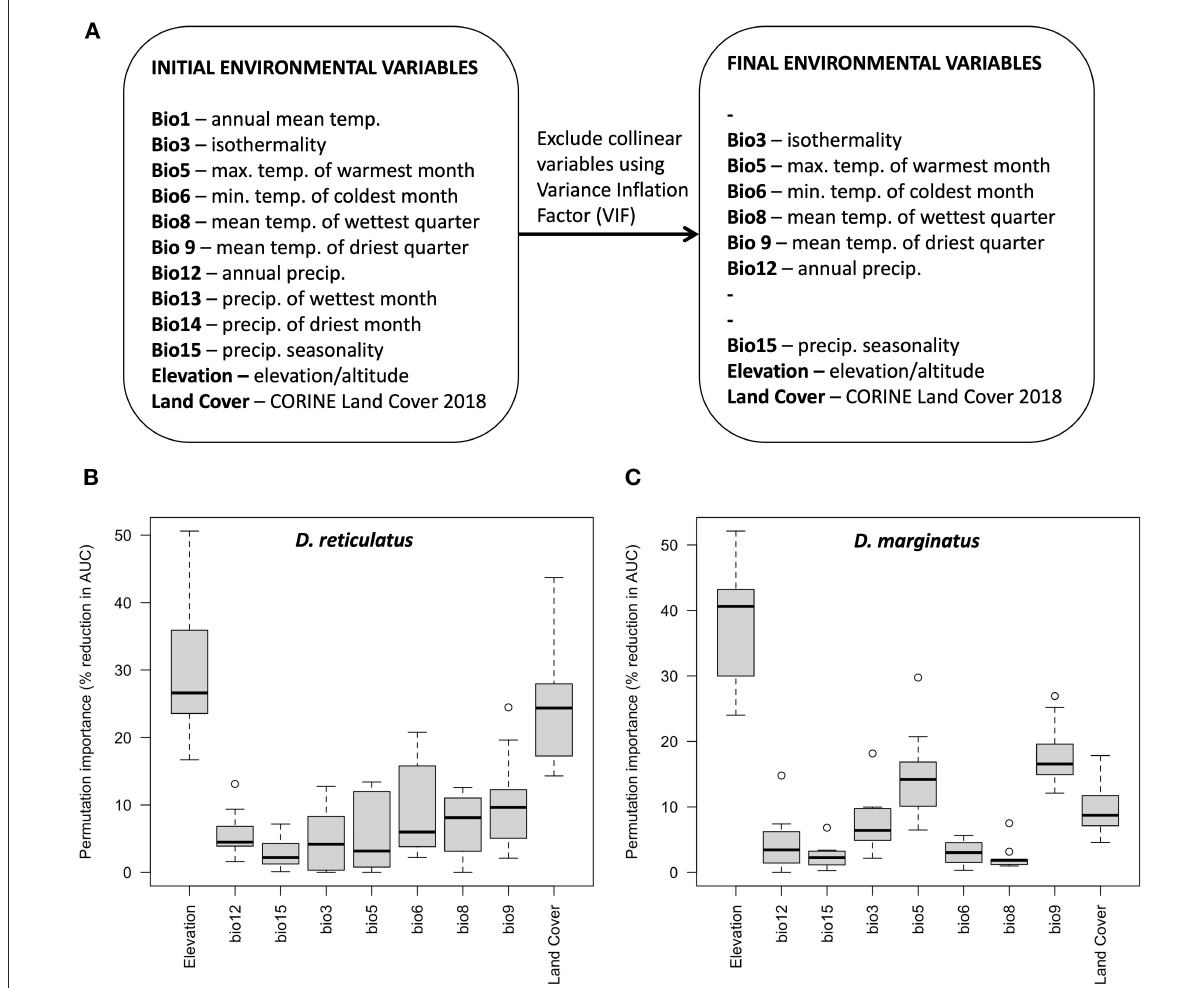
FIGURE5 Environmental variable selection for both species initially based on ecological relevance and after stepwise selection to remove collinearity based on the Variance Inflation Factor, VIF (A) ; and variable permutation importance for D. reticulatus (B) and D. marginatus (C) . The permutation importance indicates the percentage reduction in model performance (AUC) when each variable is randomly